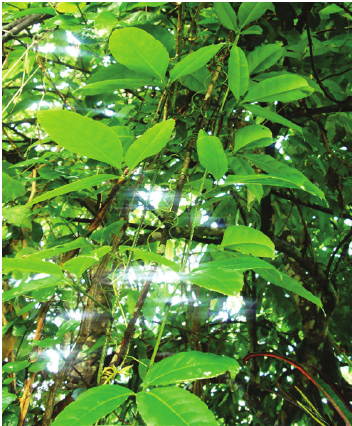
Figure 1: Tetrastigma leucostaphylum (Dennst.) Alston. (in wild) leaves are simple, defoliate, and trifoliate; all three types were found on the same plant; leaf 0–17 × 0–12; leaflets 4–13 × 2–6cm; oblong- lanceolate; base cuneate; margin coarsely serrate, especially distally; apex acute; coriaceous; the laterals unequal sided; petiole to 8cm long; warty-lenticellate; base swollen; petioules 5–14 mm